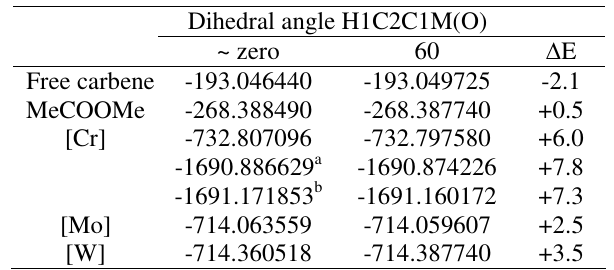
Table 2 . Energies (Hartrees) of conformers and the ∆ E in